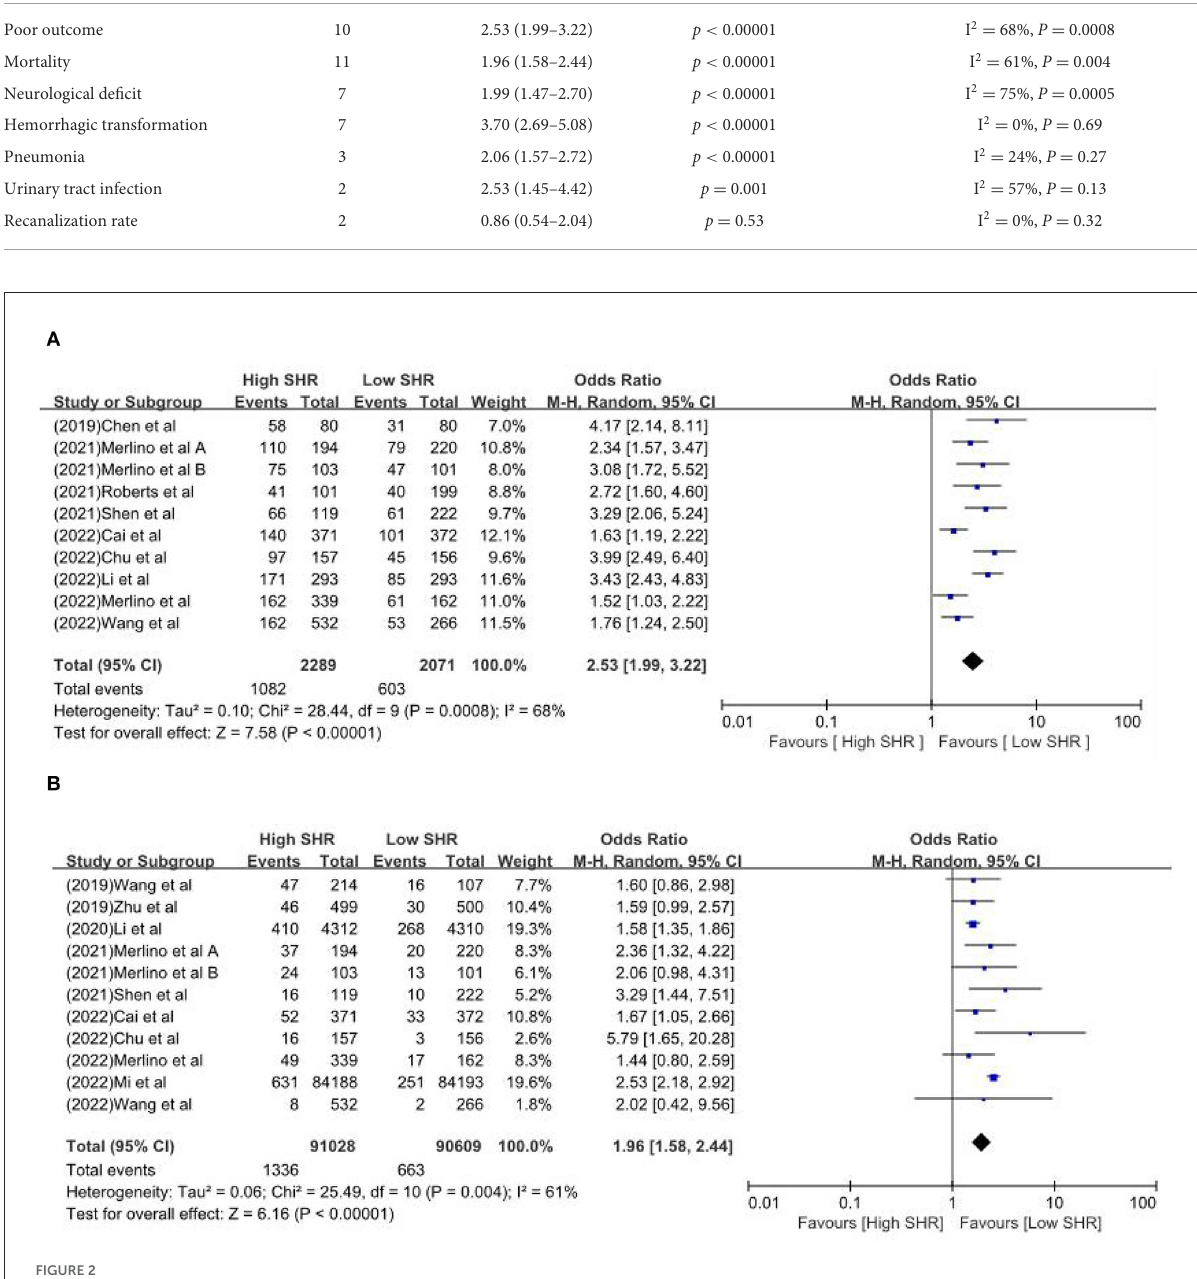
0.001, I 2 = 57%; Figure 4B] in patients with higher SHR. However, no significant benefit was observed for re-canalization rate (OR 0.86, 95% CI 0.54–1.38, P = 0.53, I 2 = 0%; Figure